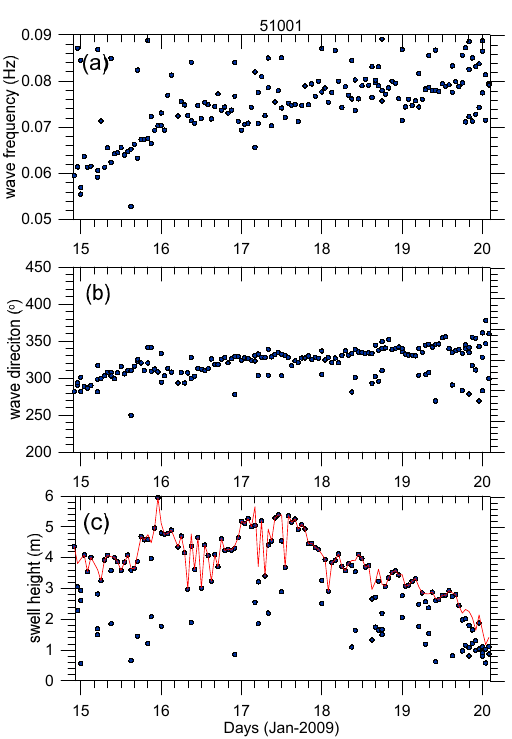
Figure 3. Swell partition integral parameters ( a ) swell peak frequency; ( b ) peak direction; and ( c ) significant swell height extracted from buoy 51001 overlaid with the total swell significant height. Only waves whose frequency are below 0.09 Hz are plotted.